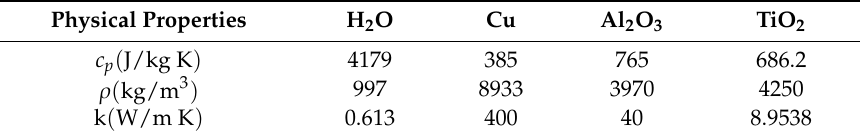
Figure 12. Effect of different nanoparticles on Table 4. Thermophysical key properties of the nanoparticles and the water (base fluid). Physical